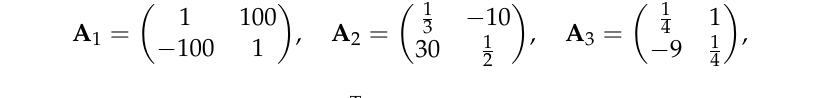
( b ) The phase diagram of switched system (8) Figure 7. The switched system (8) is asymptotically stable under the switching rule (11). Example 4. Consider a switched system (1) with the following three state matrices